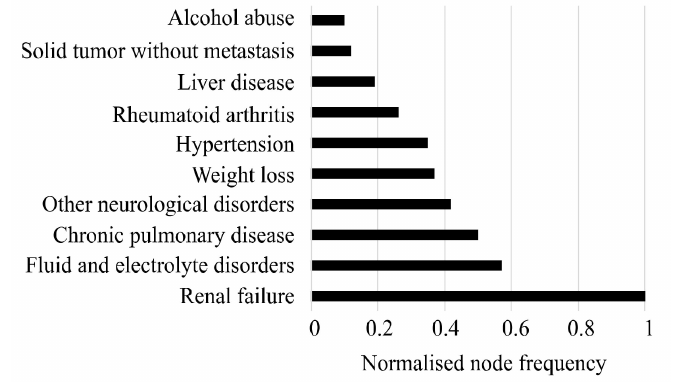
Figure 4. Top 10 comorbidities that attributed most to the progress of CVD in patients with